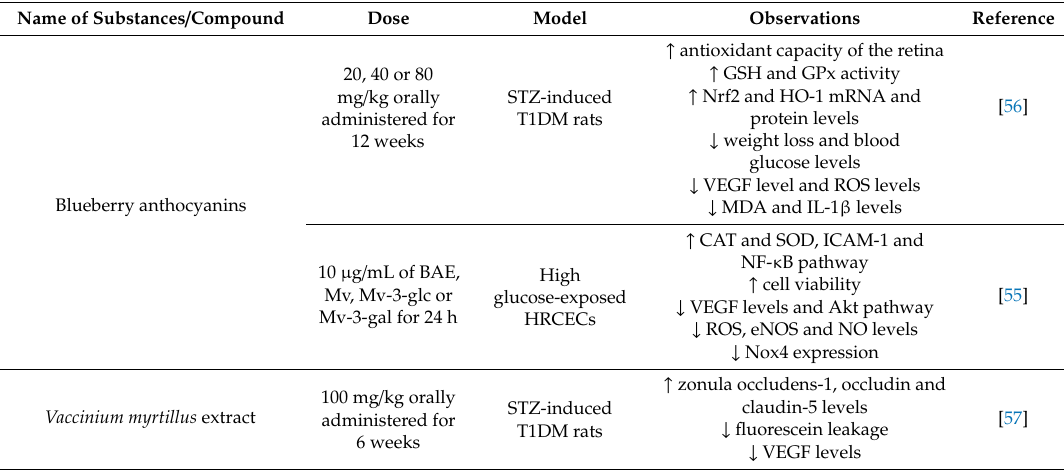
Table 1. E ff ects of anthocyanins on cellular and molecular mechanisms a ff ected by diabetic retinopathy. Name of Substances /